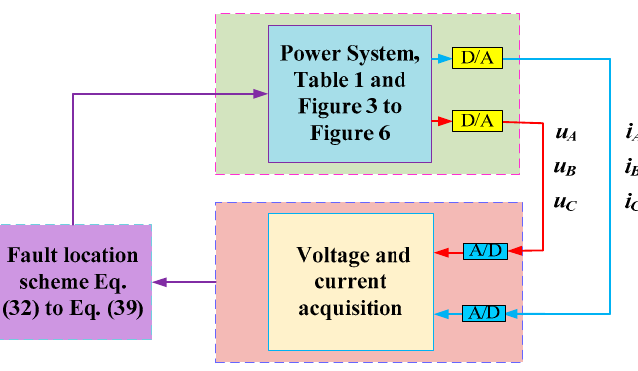
Figure 8. Configuration of the hardware-in-the-loop (HIL) test.